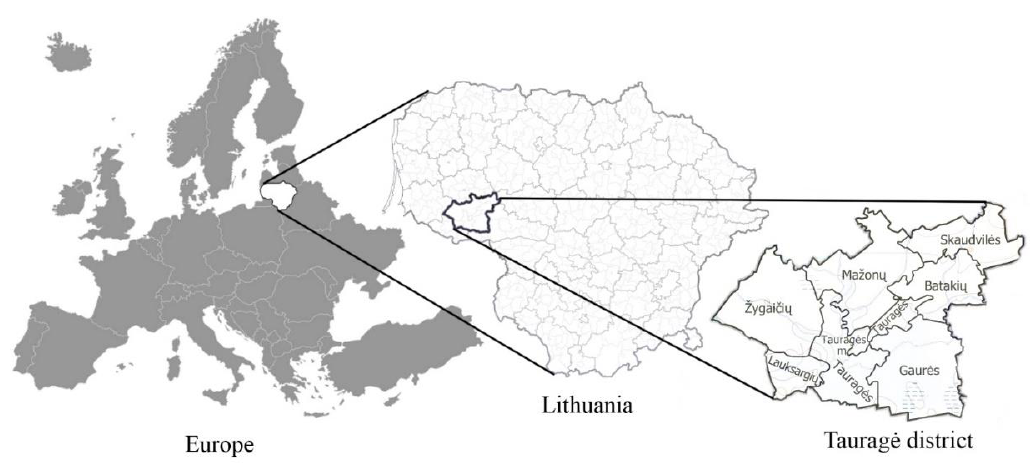
Figure 1. Study Figure 1. Study area.